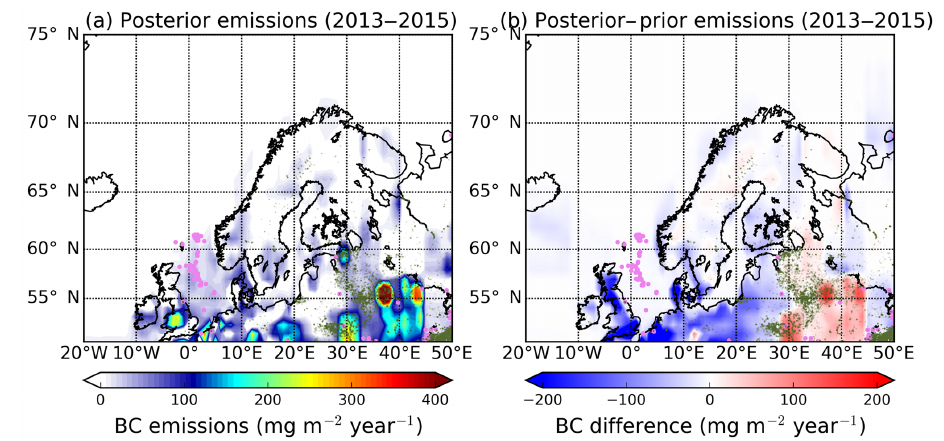
Figure 11. (a) Optimised emissions of BC in northern Europe averaged over the 2013–2015 period. (b) Difference between a posteriori and a priori emissions of BC (ECLIPSEv5 was used as the prior). Magenta points on the map indicate the gas flaring industries from the Global Gas Flaring Reduction Partnership (GGFR) (http://www.worldbank.org/en/programs/gasflaringreduction, last access: 29 February 2017), while dark green points show the vegetation fires adopted from Hao et al. (2016).